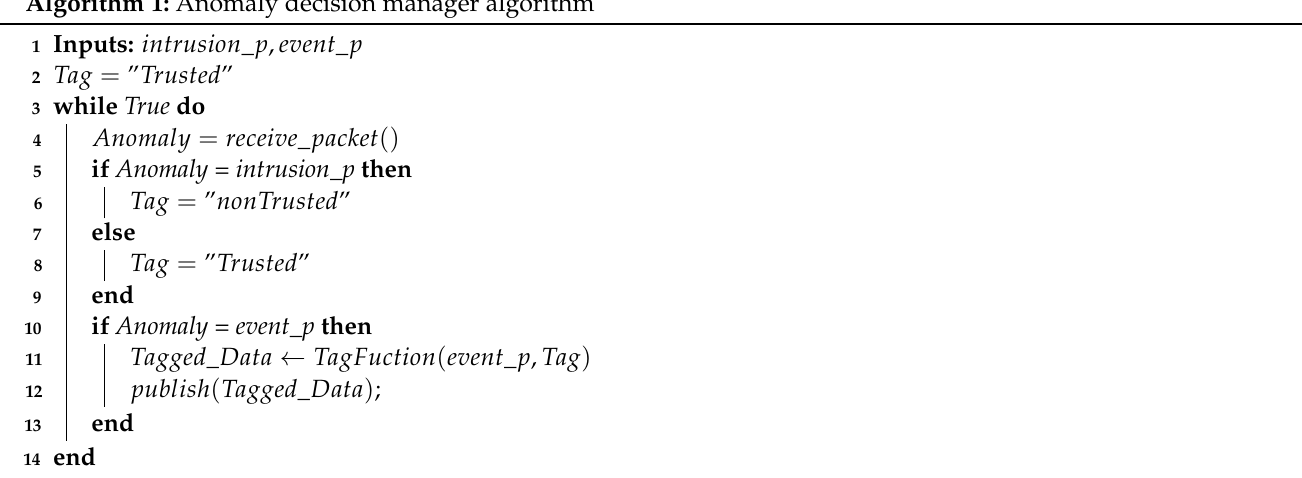
Algorithm 1: Anomaly decision manager